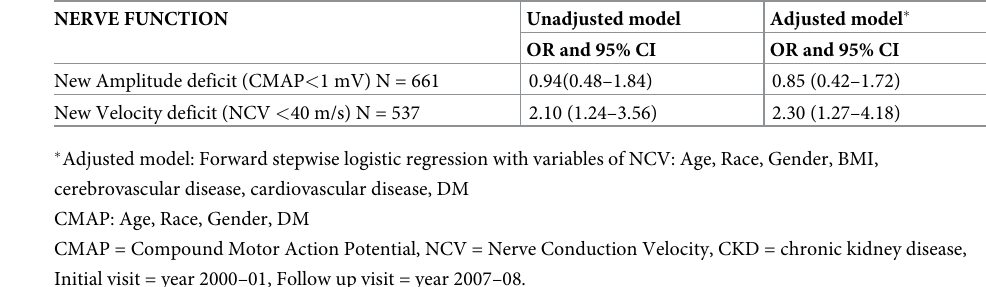
Table 2. Relationship between pre-existing CKD and new deficit in motor function at follow-up. NERVE FUNCTION